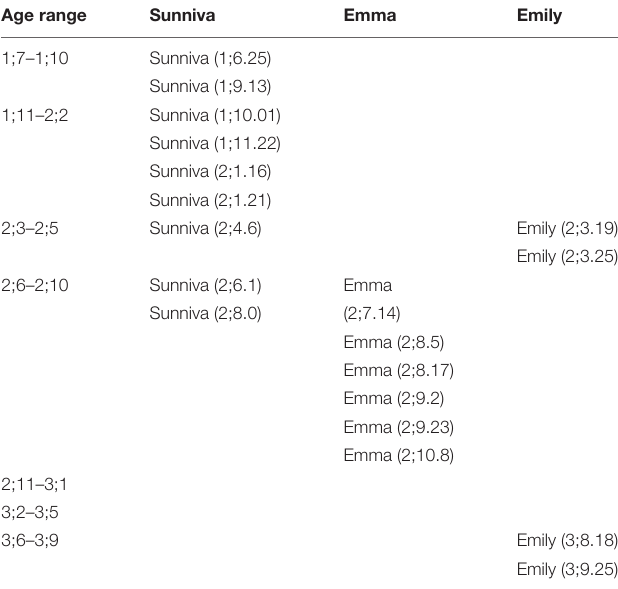
TABLE 8 | Overview of recordings according to age for Emma, Emily and Sunniva. Age range Sunniva Emma